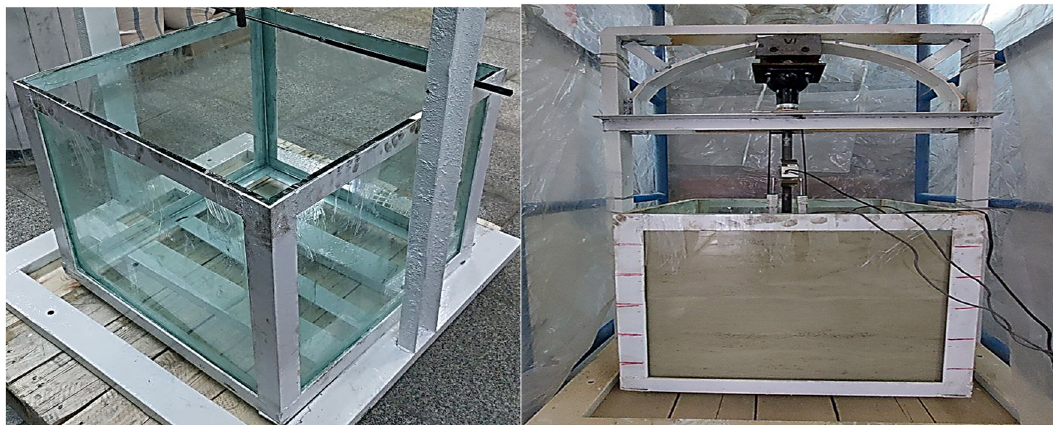
Figure 5: Glassy container and frame model.